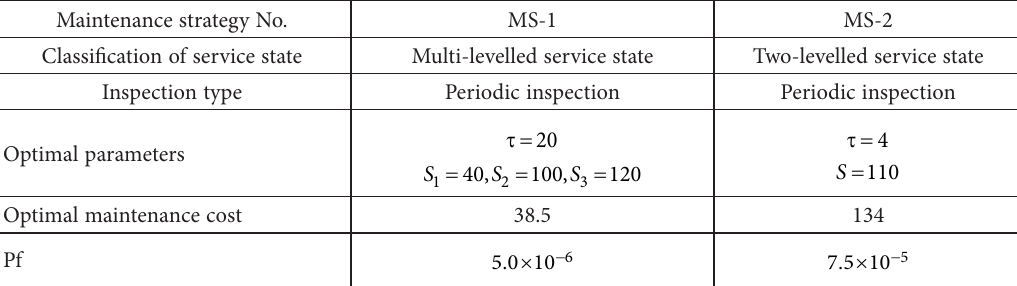
Table 8. Optimal parameters and maintenance cost for different maintenance strategies Maintenance strategy